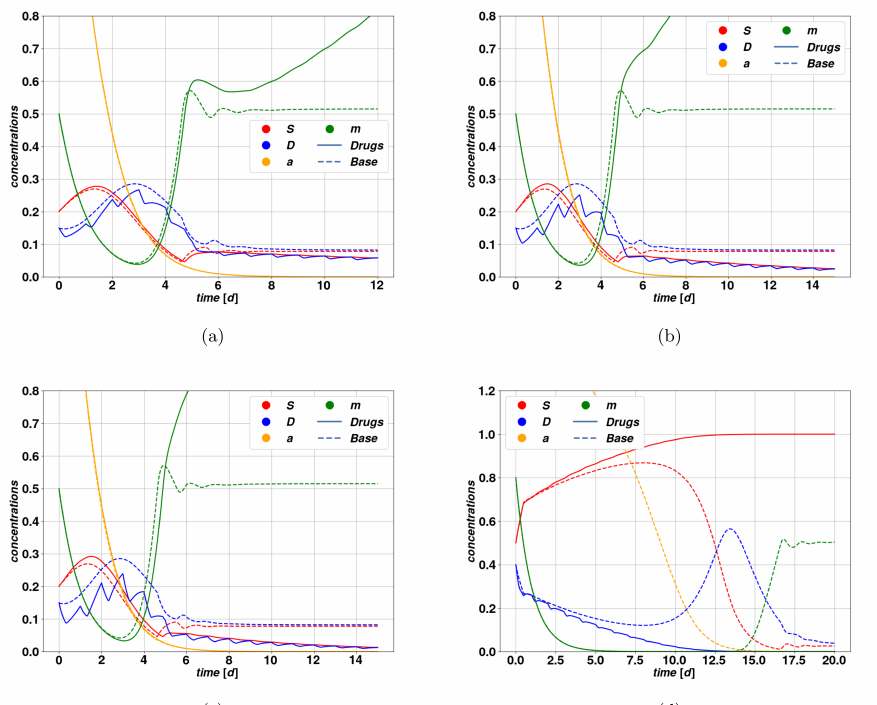
Figure 5. Trajectory overlay with cytotoxic therapy, with drug action on the parameter d (solid lines), and case without drugs (dashed lines). In all figures, we maintain the same choice of colors as previously for S , D , a and m . The system parameters are indicated in Tables 2 and 3. In three of the figures ( a – c ), we display a case where the therapy is effective in breaking the self-sustaining mitosis-plasticity loop, and leads the tumor to regression. The simulations have identical system parameters and initial conditions and only differ in the dose, expressed through χ max and the action magnitude Ω 0 of the drug. In ( a ) we have the usual scheme in Table 4; in ( b ) we changed and used χ max = 2.0 and Ω 0 = 1.5; in ( c ) we adopted χ max = 3.0 and Ω 0 = 2.0. It becomes evident by comparing the plots how despite the oscillations the cell concentrations decay significantly faster as we increase the dose and the action magnitude. The plot ( d ) results from the standard choice of drug parameters in Table 4 and outlines the tumor growth paradox, since the trajectory corresponding to the active therapy leads to the worst-case scenario of an out-of-control stem cell proliferation, with the activator a diverging and the CSC concentration reaching the upper bound, in contrast to the untreated case, where the tumor regresses in finite time after an overshoot. In this specific example, we take a large initial value of a , which in the critical case will diverge immediately, reason why it is not visible in the